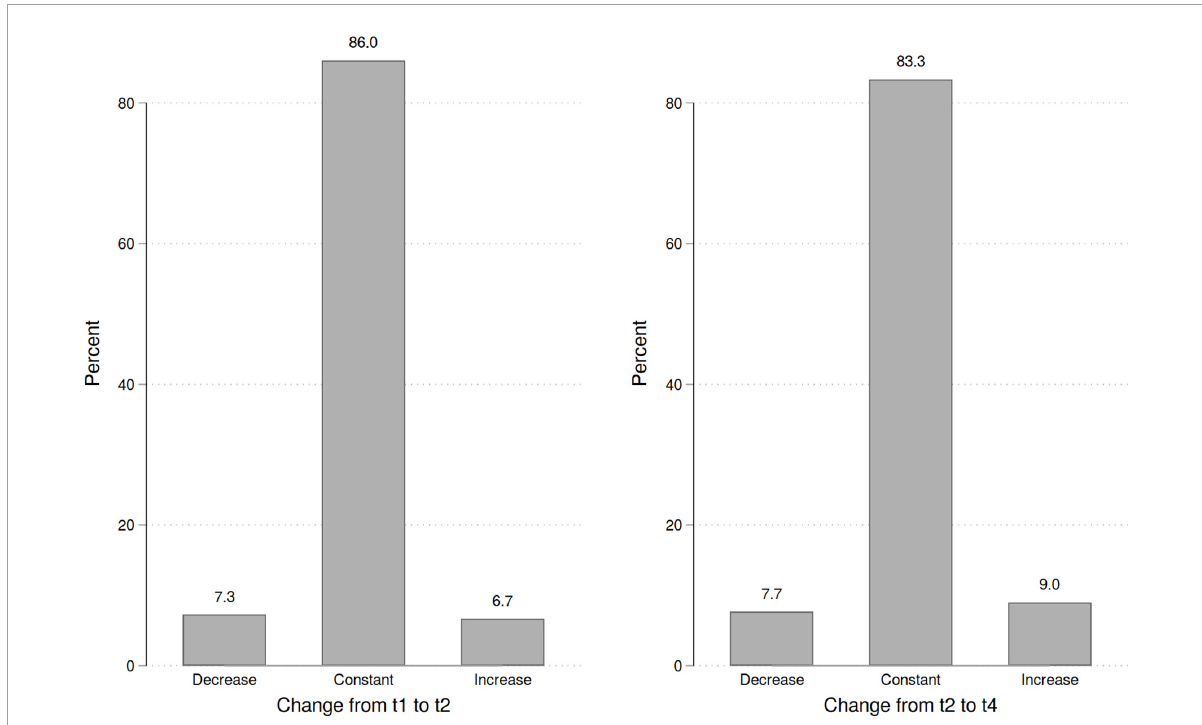
FIGURE3 Share of parents changing aspirations over timeSource: NEPS SC2, imputed data.